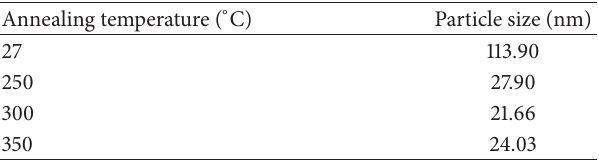
for each annealing 2